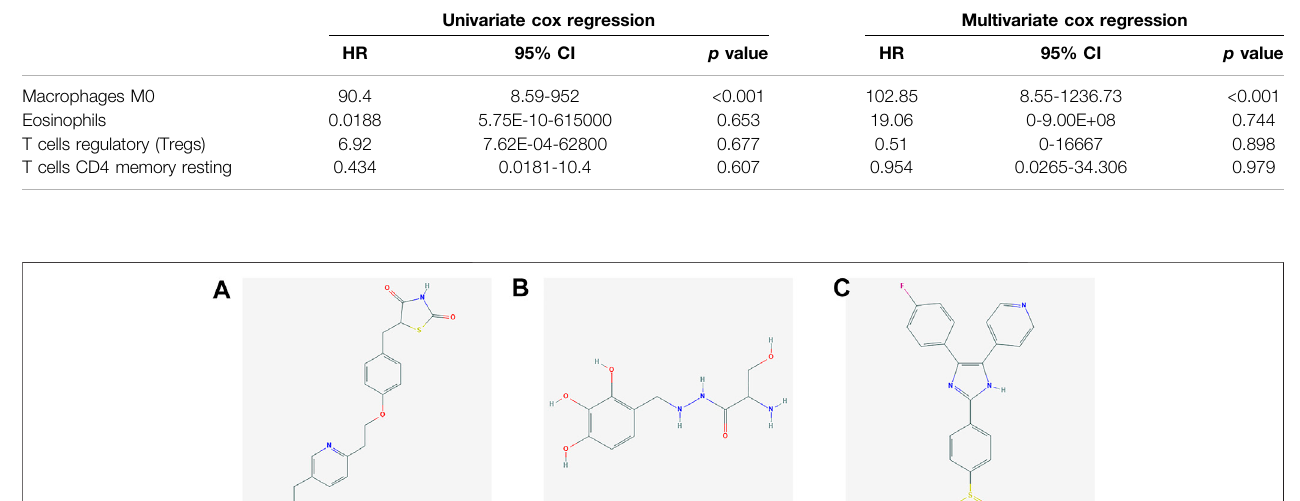
TABLE 2 | | Univariate and multivariate Cox regression analyses of four immune cells and disease-free survival of PTC patients.